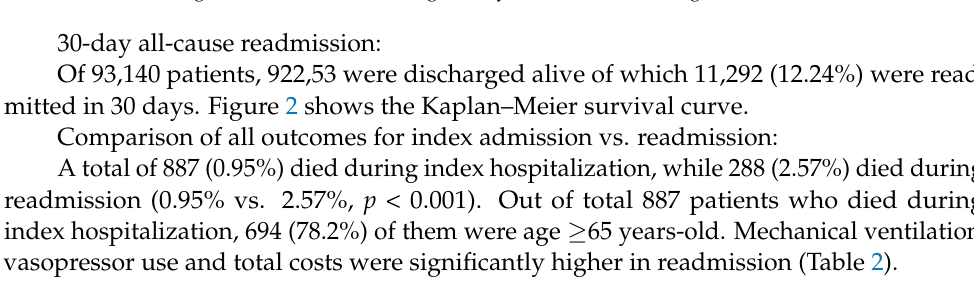
Table 2. Comparison between index admission and